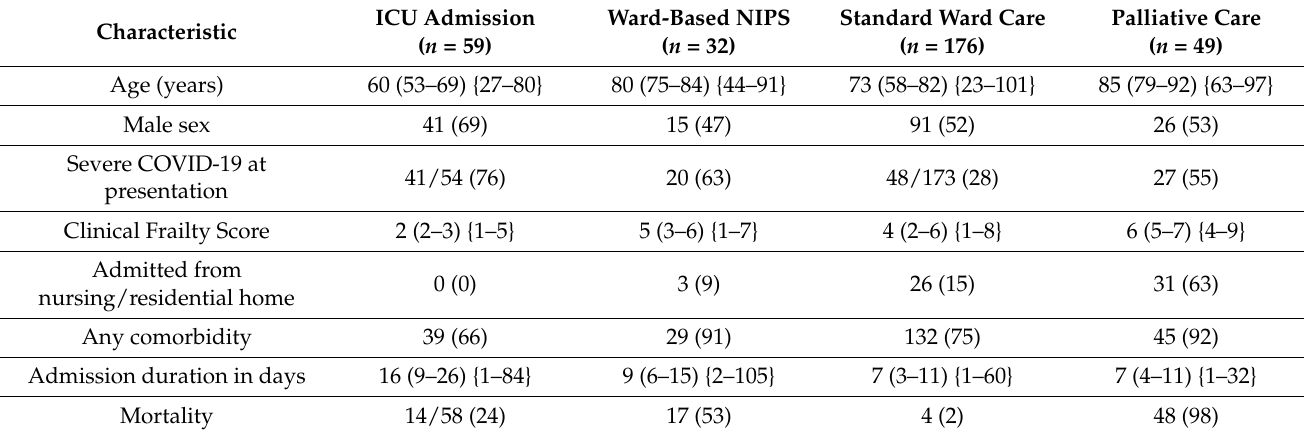
Table 2. Patient characteristics stratified by treatment group. Data are median (IQR) {range} for continuous variables, and n . (%) (or n /N (%)) for categorical